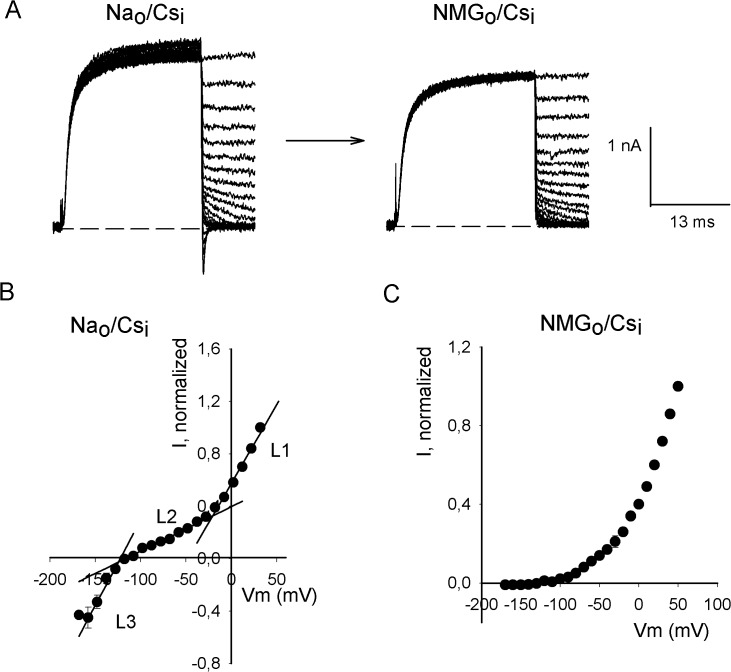
Na+ and Cs+ currents through Shab channels.(A) Currents recorded applying an instantaneous current vs. voltage protocol (IIV, see Text). Currents were recorded in the same cell in either Nao/Csi (left panel) or NMGo/Csi solutions (right panel). Scale bars are the same for both panels. (B) Average normalized IIV obtained from independent experiments as in the left panel of A (n = 7). L1 to L3 are least squares lines that fit the indicated regions: L1(Vm) = 0.012 Vm + 0.48; r = 0.994; L2(Vm) = 3.4x10-3 Vm + 0.37; r = 0.992; L3(Vm) = 0.013 Vm + 1.49; r = 0.990. (C) Average normalized IIV obtained from 4 independent experiments as in the right panel of A.